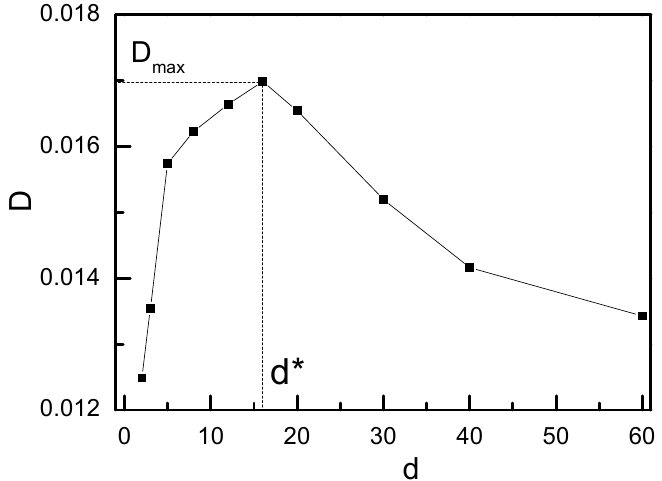
Figure 3. Diffusion coefficient Dof ring chain on the symmetricfixed rod-like chains(K 1 = K 2 = ∞ ) with different distances d between two symmetricfixed rod-like chains.